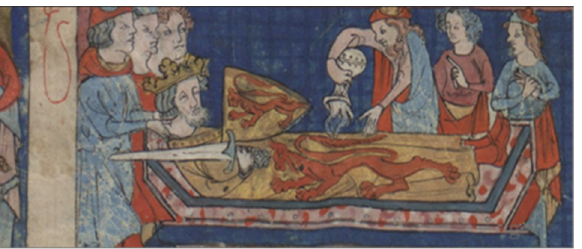
Figure 17. Miniature from the Roman de toute chevalerie by Thomas de Kent depicting the funeral of Phillip II, Alexander’s father.